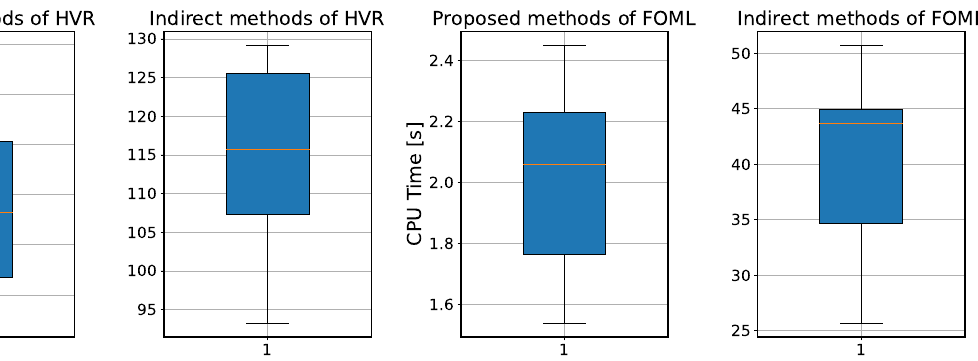
Figure 13. Comparison of the solving efficiency between the proposed method and the indi- rect